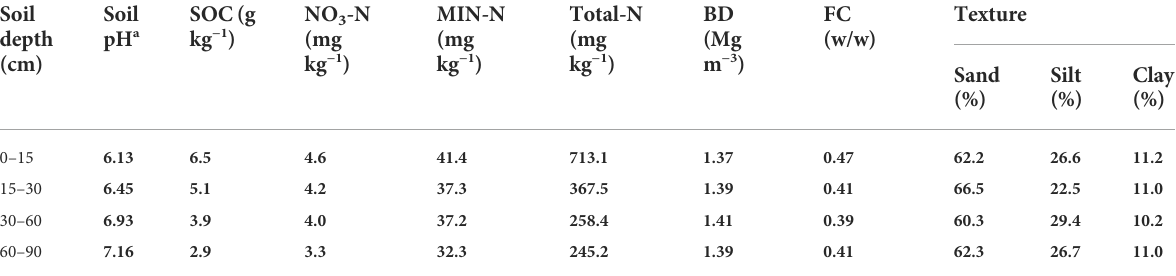
TABLE 1 Physicochemical properties of the experimental fi eld at the start of the experiment during the fi rst year of the study. Soil